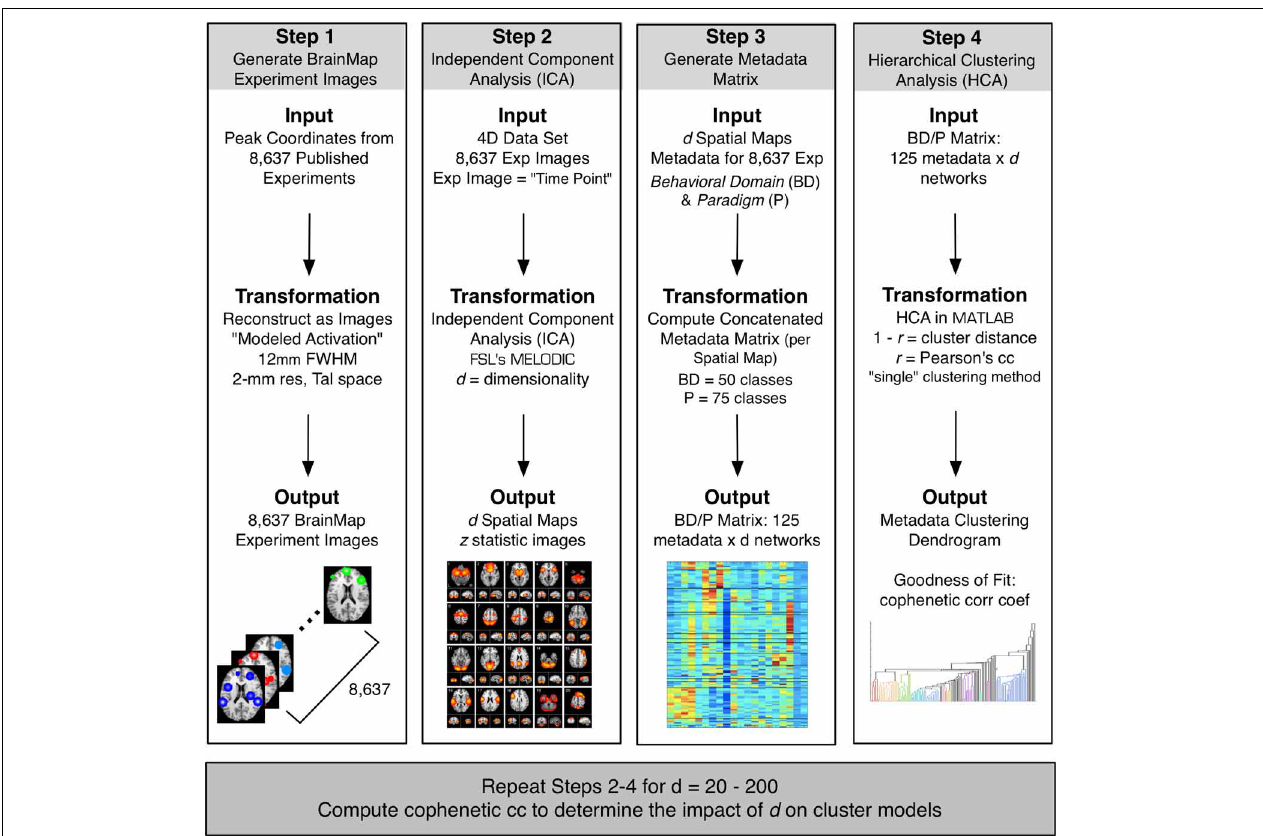
FIGURE 1 | The BrainMap ICA processing stream included four steps. Step 1: Peak activation coordinates from 8,637 experiments in the BrainMap database were smoothed at a FWHM of 12mm to create a 4D modeled activation map (space × experiment ID). Step 2: ICA was applied to the 4D data using FSL’s MELODIC at a model order of d to create a set of d spatial components. Step 3: Metadata matrices were created at each d weighting